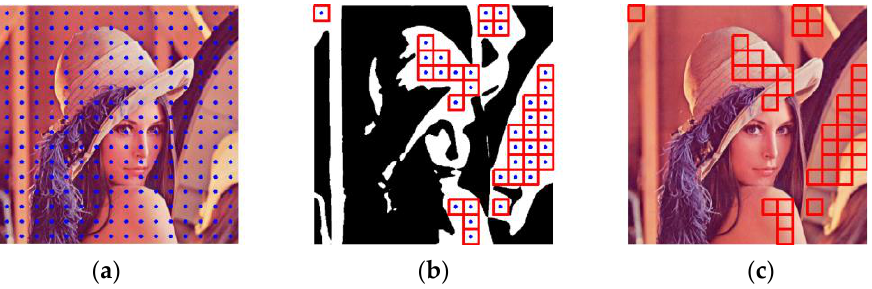
Figure 6. Applying a mask in sliding mode: ( a ) source image with the candidate patch positions marked with blue dots; ( b ) a binary mask with the patches that fit in the white (allowed) areas; ( c ) the resulting extracted patches.